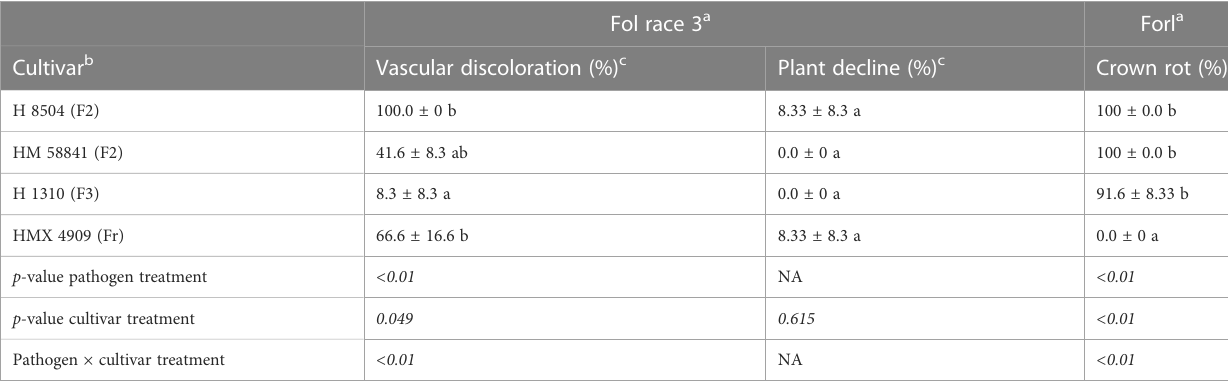
TABLE 5 Phenotyping with a young plant single-pot plant assay of four tomato cultivars inoculated with different formae specialis of Fusarium oxysporum